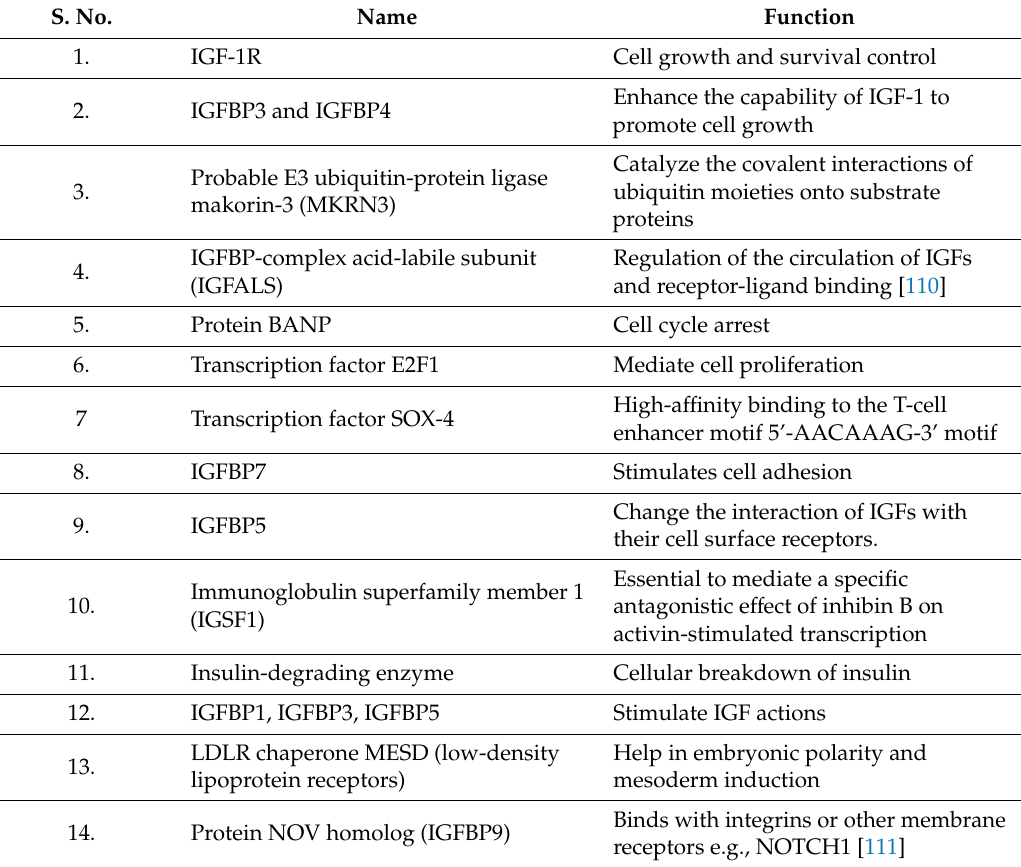
Table 2. Function of IGF-1 related